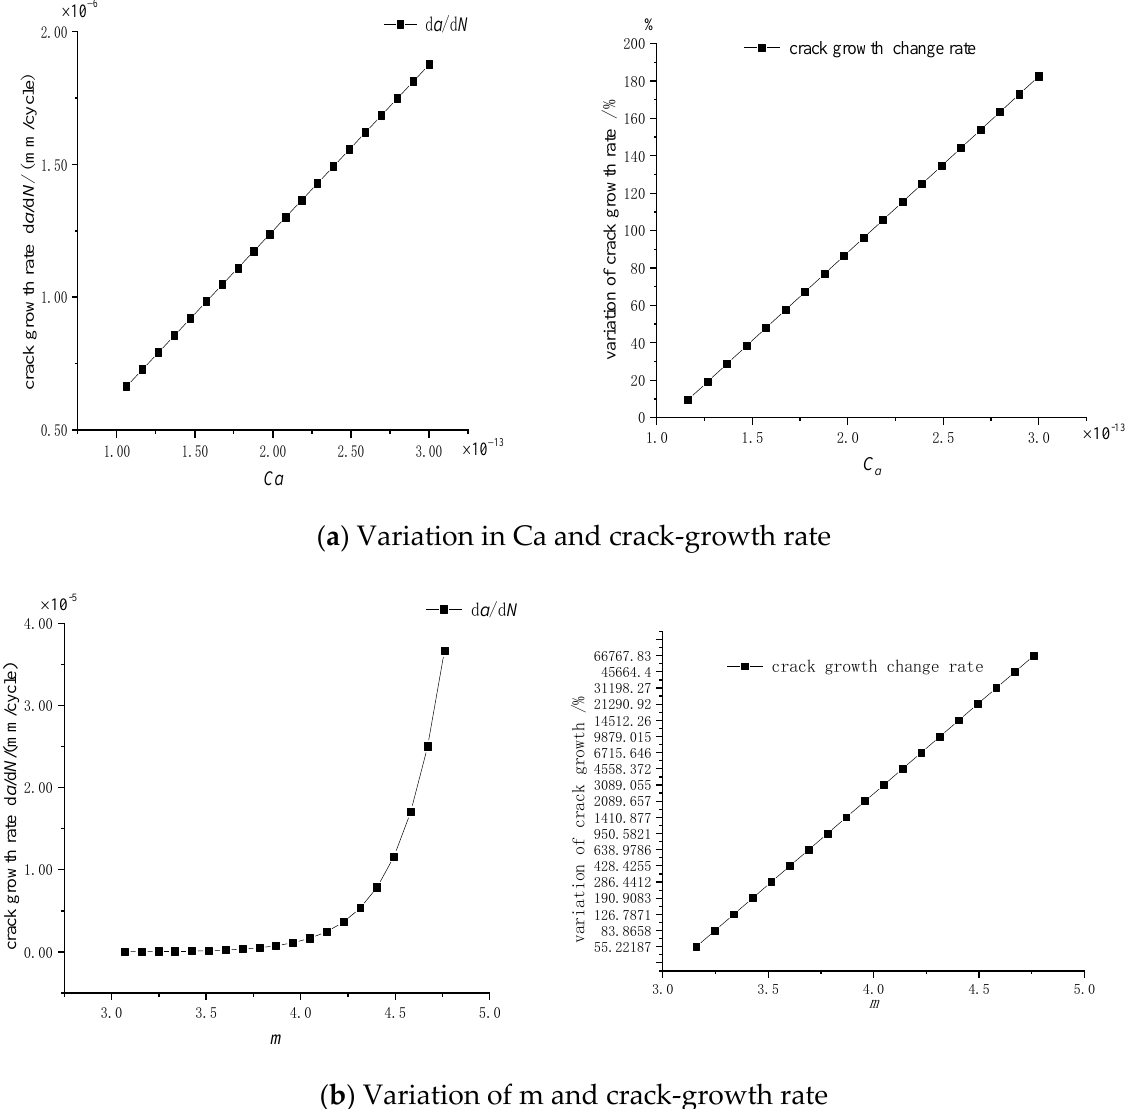
Figure 11. The effect of parameters changes on the growth rate: ( a ) Variation in Ca and crack-growth rate ( b ) Variation in m and crack-growth rate.